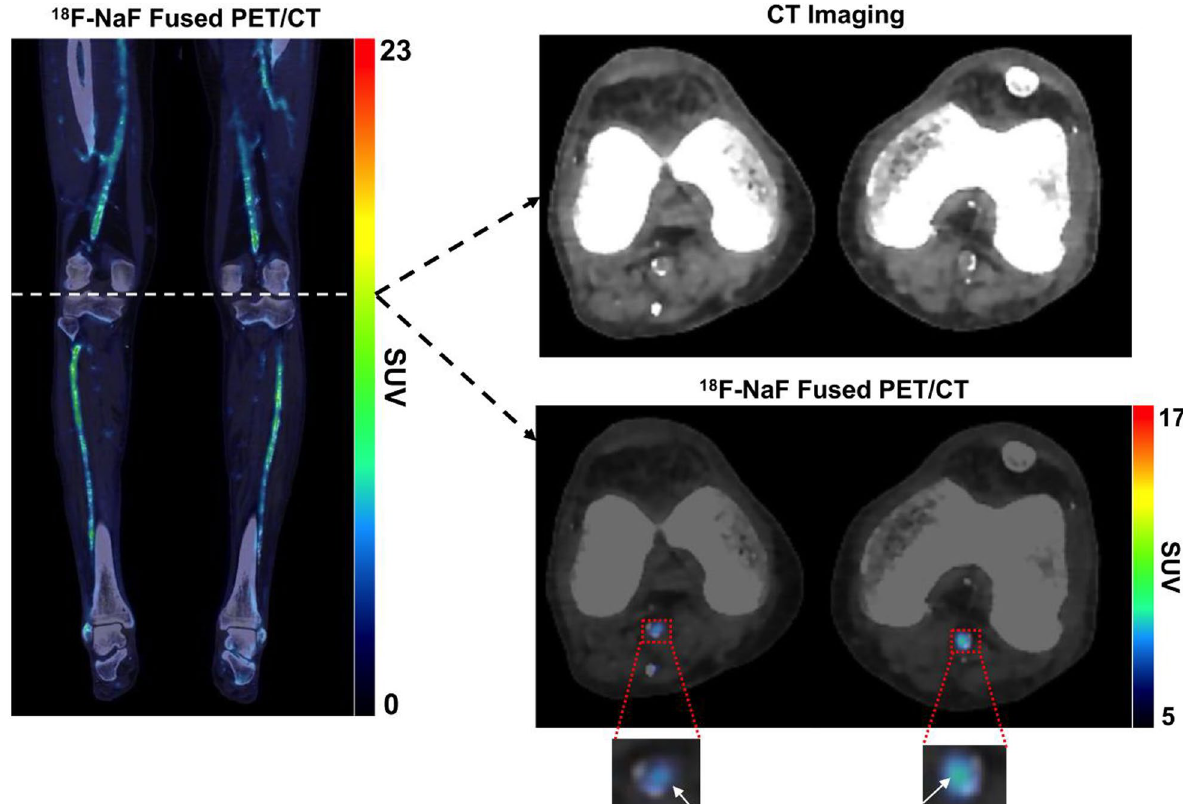
Fig. 2 Representative 18 F‑NaF PET/CT imaging of the lower extremities in a patient with PAD and DM. Fused coronal 18 F‑NaF PET/CT imaging of both lower extremities demonstrated heterogenous macrocalcification detected by CT imaging and heterogenous arterial uptake of 18 F‑NaF detected by PET. Focused axial images at the level of the knee further revealed that increased 18 F‑NaF uptake was localized to arterial regions undergoing active microcalcification and were not yet fully detectable by CT imaging (denoted by white